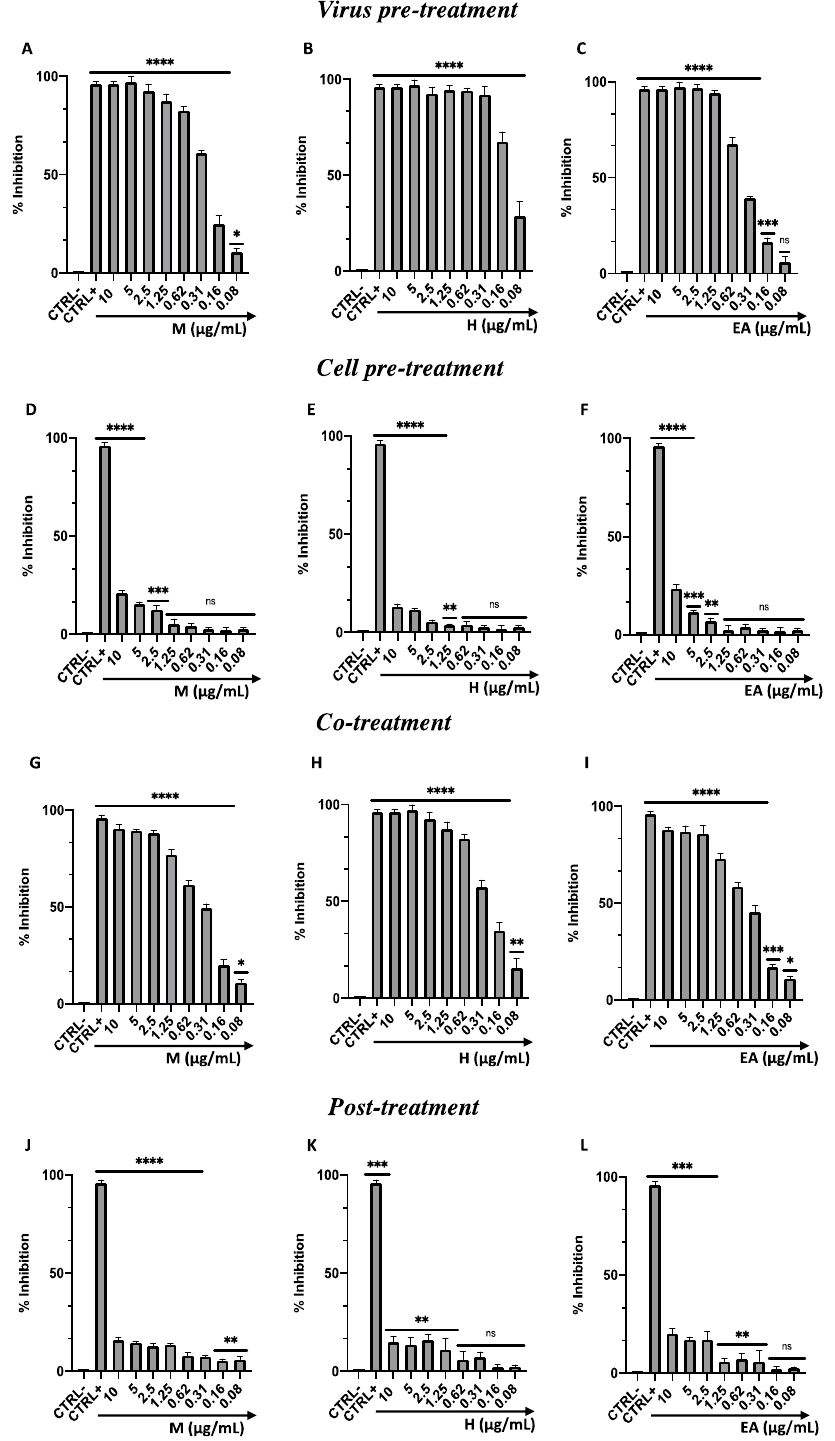
Figure 2. Antiviral activity of M, H, and EA from F. rubiginosa L. extract against HSV-1. Four